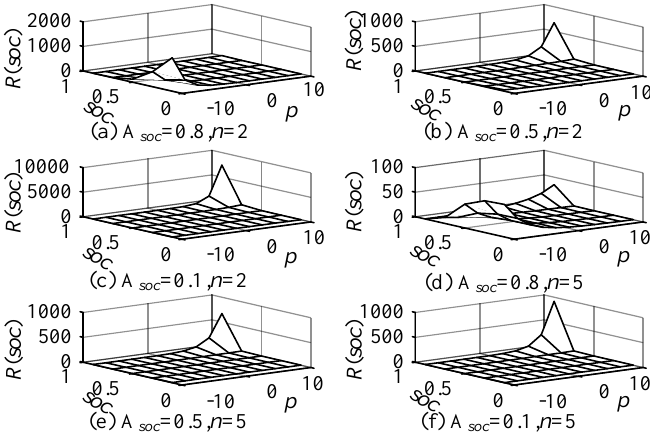
Figure 8. k D = 2.5, soc = 0.1~0.95, p = − 10~10, mesh of R ( soc